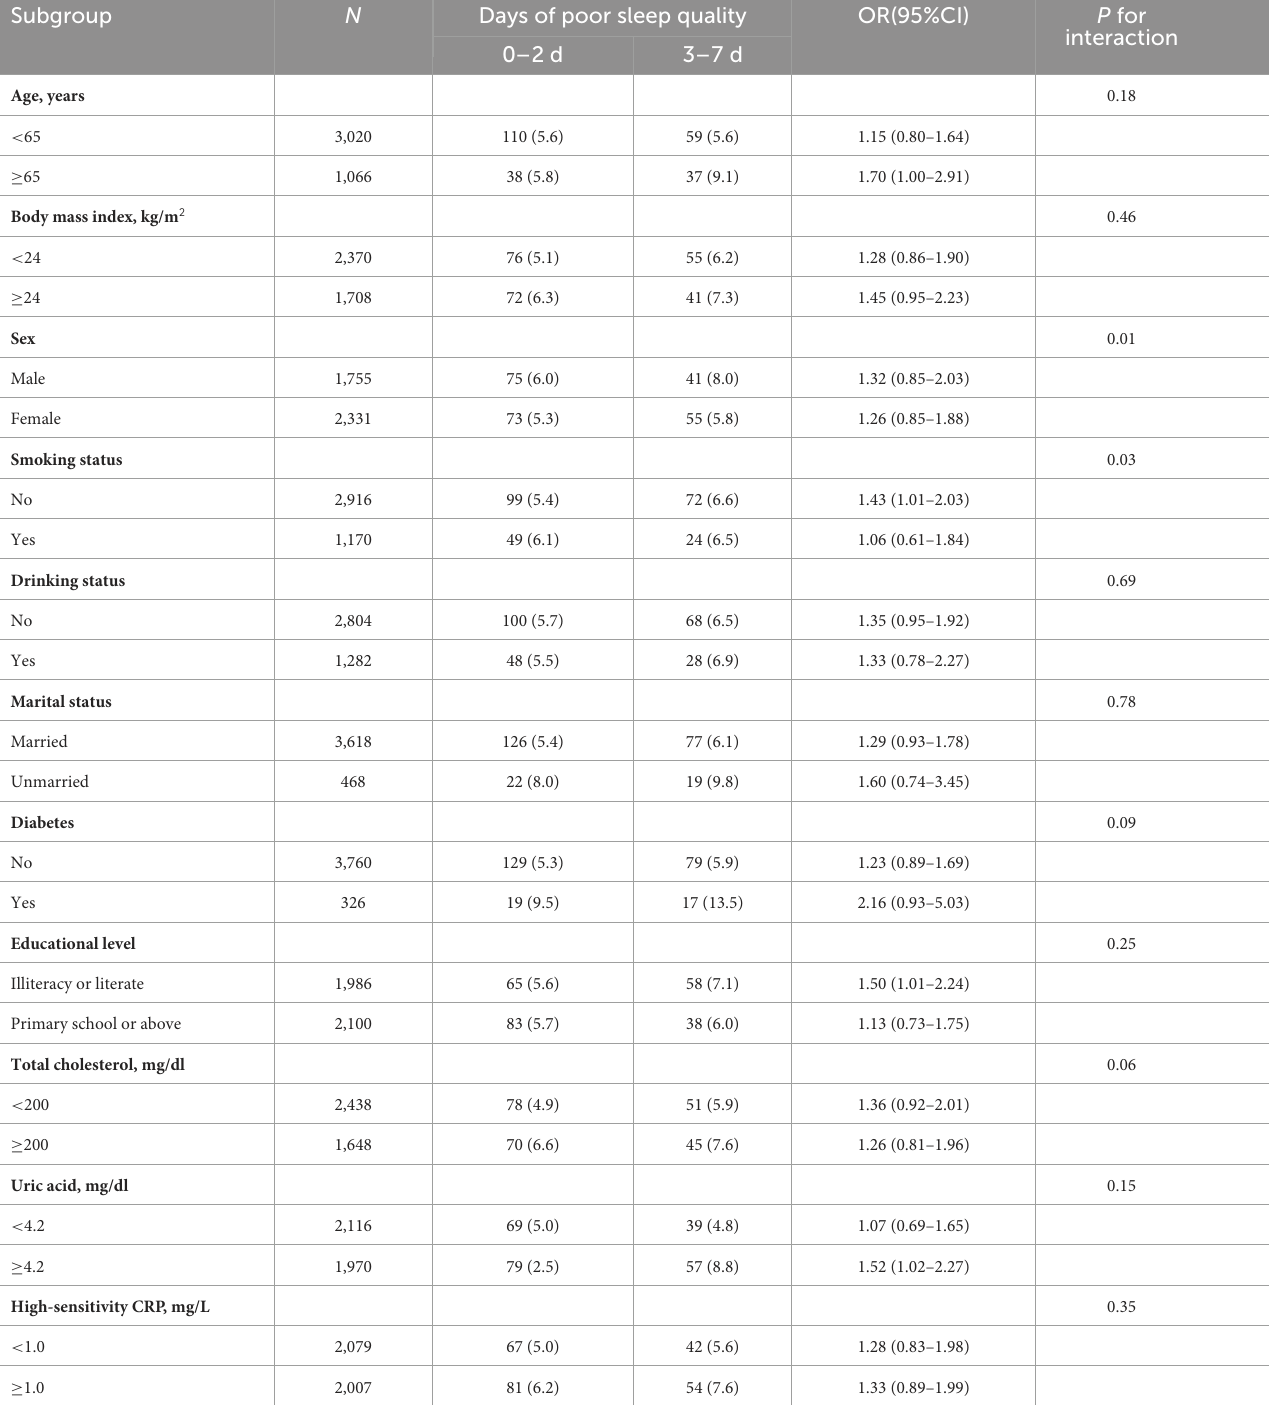
TABLE 5 Stratified analyses for the association between days of poor sleep quality and rapid kidney function